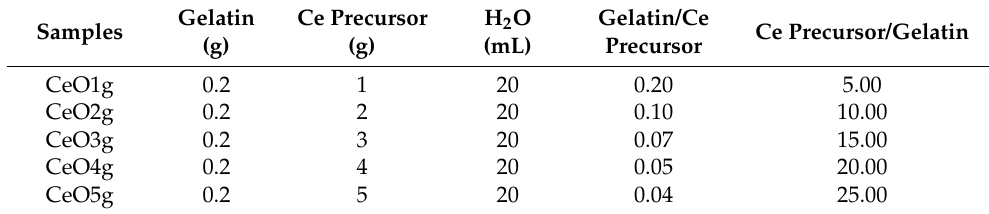
Table 1. Amounts of gelatin, Ce precursor, and solvent along with ratios of Gelatin and Ce